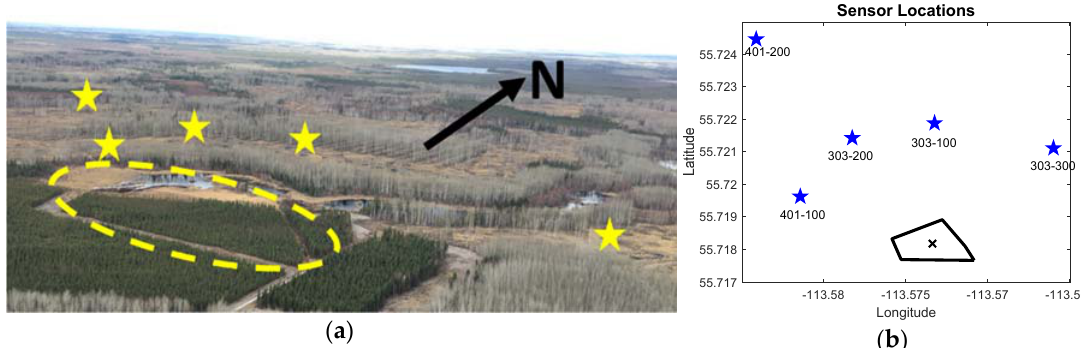
Figure 1. ( a ) Image of Pelican Mountain unit 5 prescribed fire area, micro-station deployment locations are marked; ( b ) location coordinates of unit 5 and the sensor systems, cross mark (x) in the figure refers to the assumed center of the fire area from where all distances are measured.